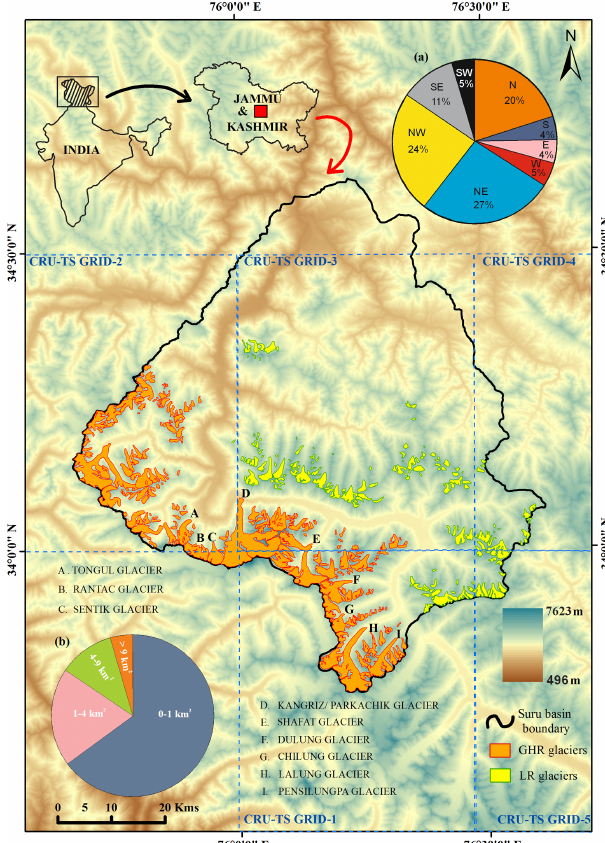
Figure 1. Location map of the study area. The glaciers in the Suru sub-basin (SSB: black outline) are studied for their response to- wards the climatic conditions during the period 1971–2017. Blue rectangles with dashed outlines (GRID-1, 2, 3, 4 and 5) are the Cli- mate Research Unit (CRU) time series (TS) 4.02 grids of dimen- sion 0 . 5 ◦ × 0 . 5 ◦ . (a) Pie chart inset showing orientation-wise per- centage distribution of glaciers in the sub-basin. North (N), north- east (NE), north-west (NW), south (S), south-east (SE), south-west (SW), east (E) and west (W) represent the direction of the glaciers. (b) Pie chart inset showing size distribution of glaciers in the SSB. The glacier boundaries GHR (orange) and LR (yellow) are overlain on the Advanced Land Observing Satellite (ALOS) digital surface model